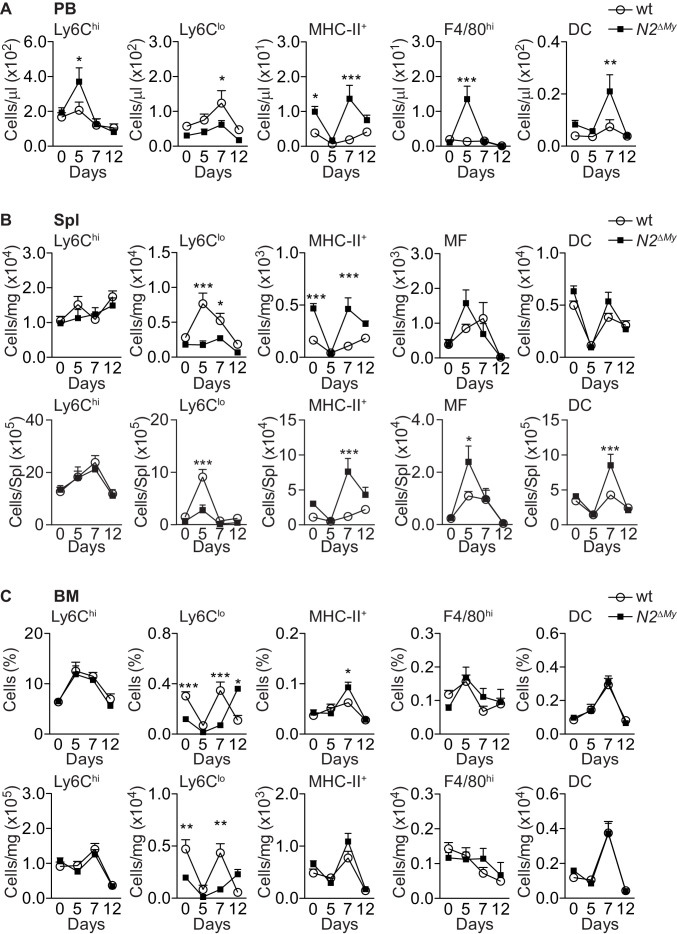
Flow cytometry analysis of myeloid cells in IMQ-driven inflammation.(A) Absolute frequency of different myeloid subpopulations in PB. (B) Absolute frequency of different myeloid subpopulations normalized per mg tissue (top) or per spleen (bottom). (C) Relative (top) and absolute (bottom) frequency of different myeloid subpopulations in the bone marrow of Sham- or IMQ-treated mice are shown. (A–C) data are pooled from six experiments (n = 7–18). *p<0.05, **p<0.01, ***p<0.001; two-way ANOVA with Bonferroni’s multiple comparison test.